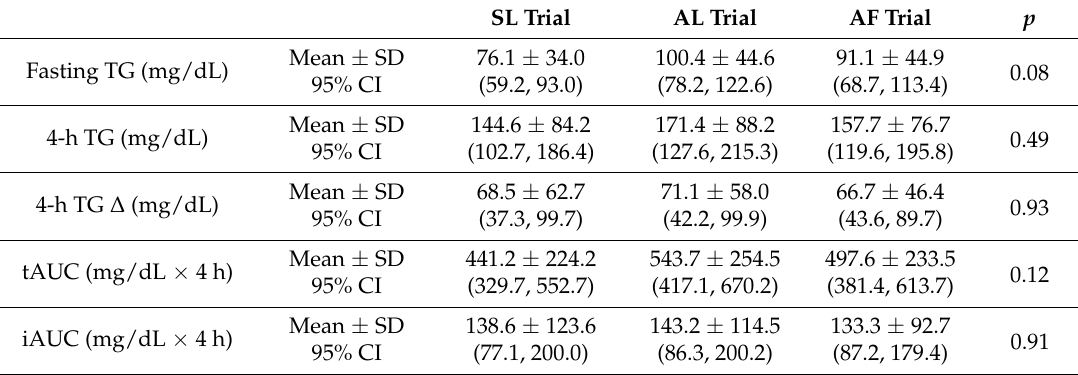
Table 2. Fasting triglyceride levels and postprandial